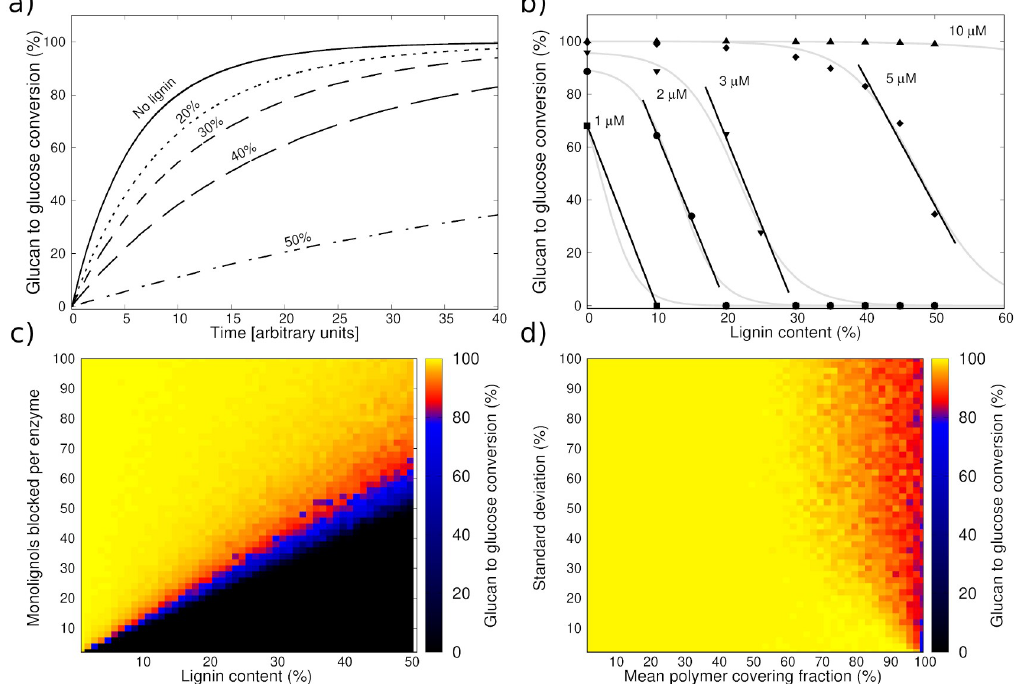
Fig 7. (a) Simulated saccharification time courses for increasing lignin percentage up to a time t end = 40 (arbitrary units). Each curve represents an average over 100 simulation runs. (b) Simulated glucan to glucose conversion at time t end versus lignin content for five different values of the overall enzyme concentration [ E ]. The gray lines trace the inverse logistic behavior, while the black lines indicate the approximately linear intermediate regimes. Each point represents an average over 100 simulation runs. (c) Simulated glucan to glucose conversion at time t end versus lignin content and number of monolignols involved in the binding of a single enzyme ( N lignols,bound ). Enzyme concentration is: [ E ] = 5 μ M. (d) Simulated glucan to glucose conversion at time t end versus mean polymer covering fraction and its standard deviation (see also section 2.3). The lignin content is 50%, and the enzyme concentration is [ E ] = 5 μ M. In (c) and (d) each pixel represents an average over 10 simulation